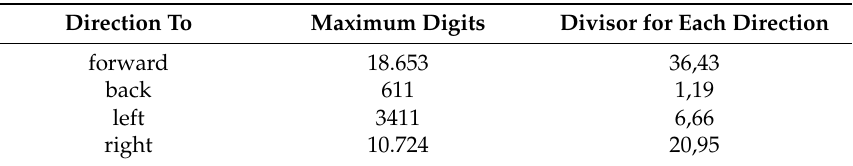
Table 3. Patient measurements and calculated